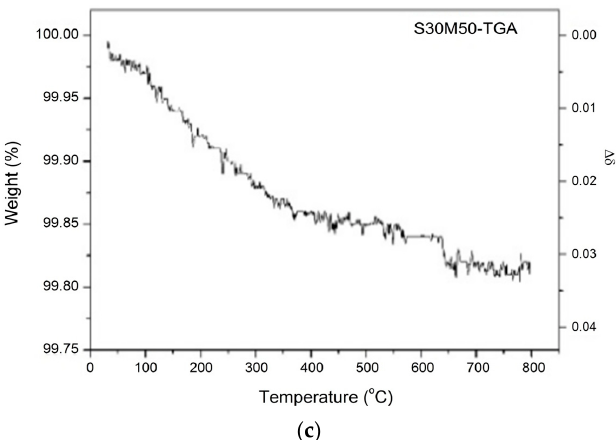
( c ) Figure A3. TGA and oxygen deficient ( Δδ ) curve of: ( a ) S30; ( b ) S30C4; and ( c ) S30M50 measured from Figure A3. TGA and oxygen deficient ( ∆ δ ) curve of: ( a ) S30; ( b ) S30C4; and ( c ) S30M50 measured from room temperature to 800 °C room temperature to 800 ◦